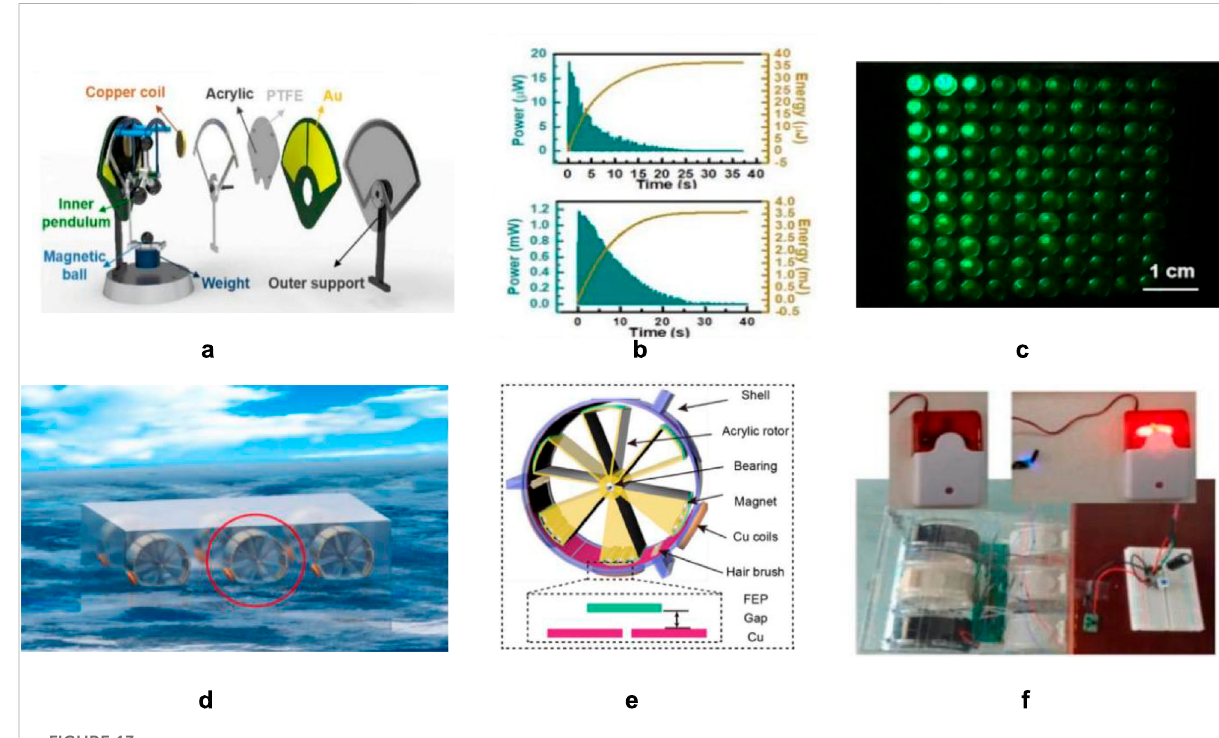
FIGURE 13 (A) Structure of the hybrid nanogenerator based on the disorder pendulum. (B) Output power and conversion energy of the TENG and EMG underwaterwavetriggeringwithanimpedanceof400 M Ω . (C) Lightingof100LEDsunderwaterwavetriggering(ChenXetal.,2019). (D) Schematic diagram of the hybrid nano-generator and its application in wave energy harvesting. (E) Diagram of the hybrid nanogenerator structure (enlarged viewshowingthegapbetweentheFEP fi lmandthecopperelectrode. (f) Poweringawirelesstransmitterbycharginga1,000 μ Fcapacitor(Feng et al.,